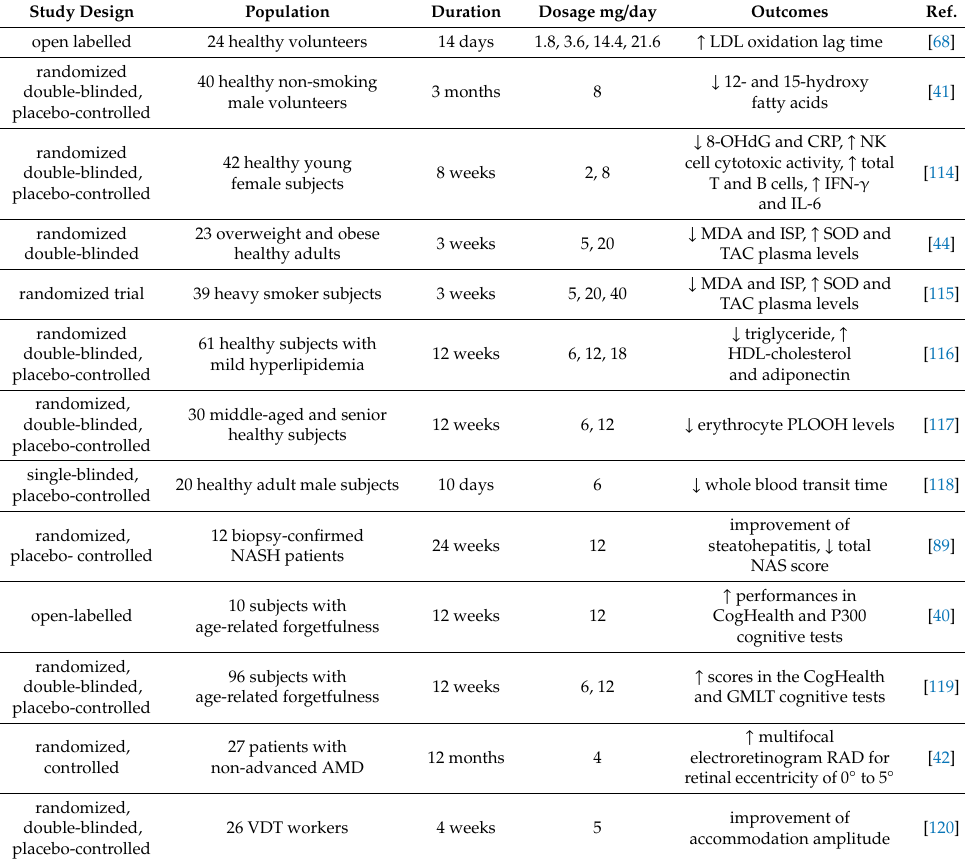
Table 2. Summary of clinical studies investigating the biological activities of